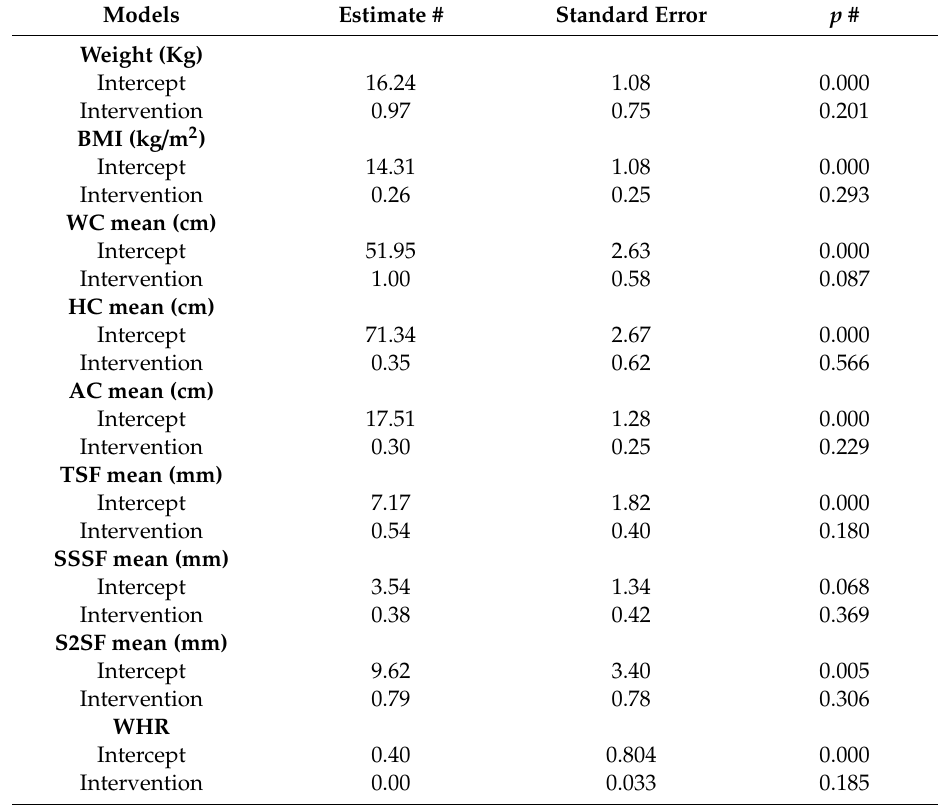
Table 5. Estimates ( β ) and standard errors to assess the e ff ects of a program StayingFit on the anthropometric parameters of study adolescents. Salvador -BA,